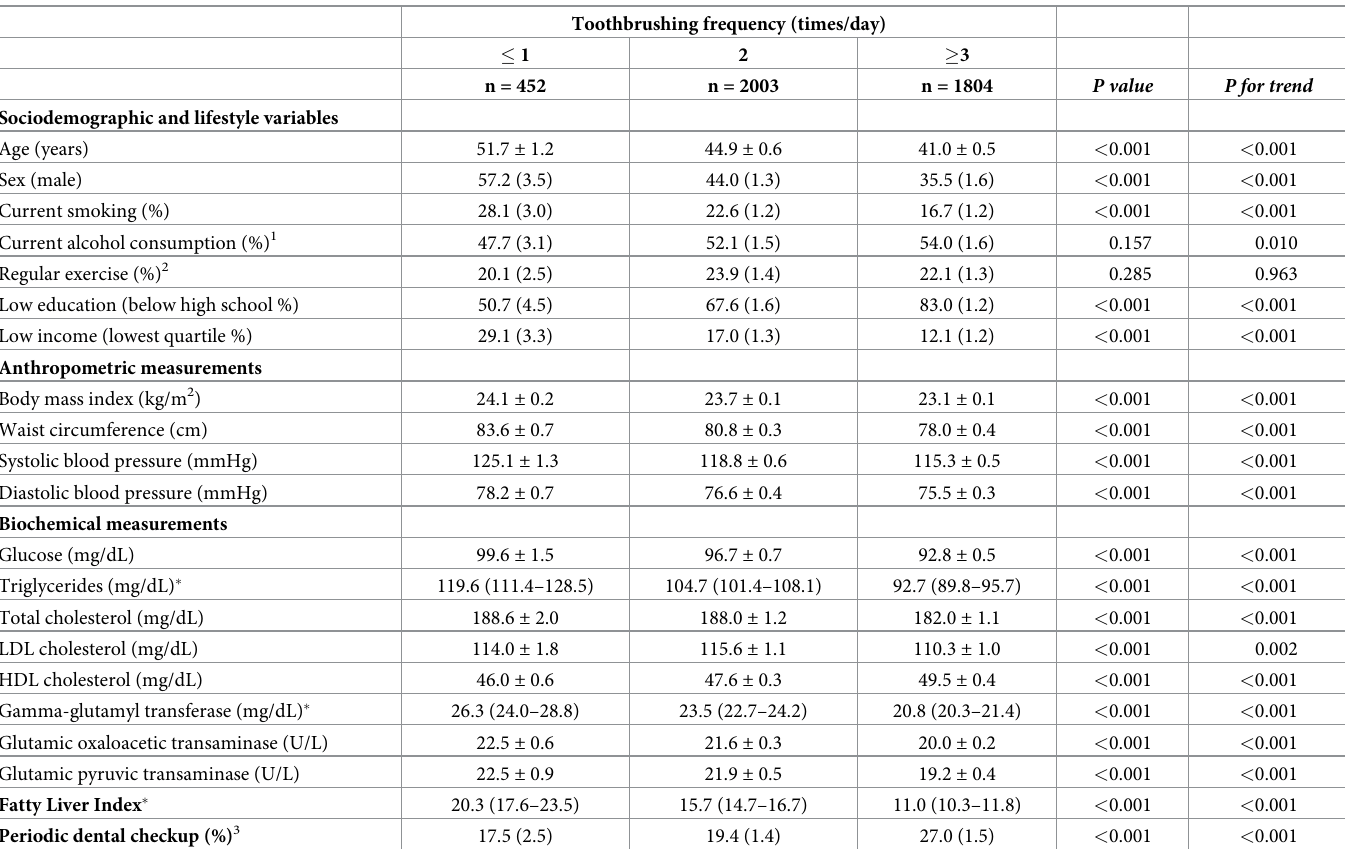
Table 1. Baseline characteristics of the study participants.